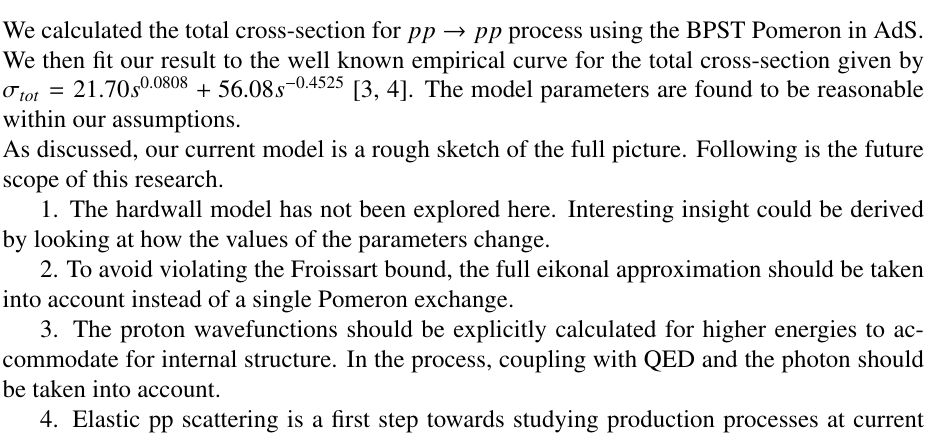
Figure 1. The blue line corresponds to the true fit while the red line corresponds to our current model. The values found for the model parameters are tabulated